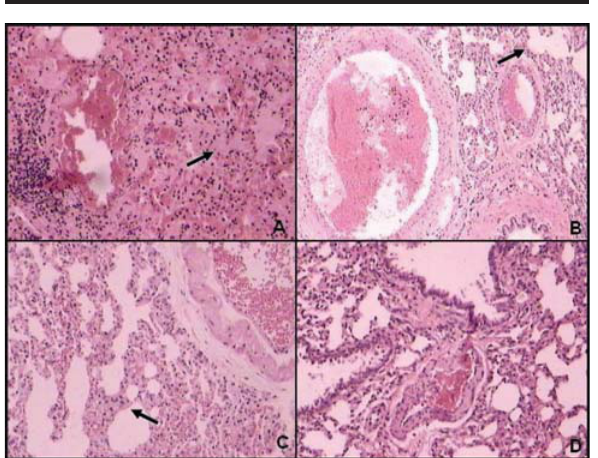
FIGURE 2 - Microscopy of the pulmonary sections of the group 10mg/kg. A) 08 weeks. The arrow shows lymphoid nodular hyperplasia (BALT hyperplasia). B) 10 weeks. Diffuse chronic inflammatory process. The arrow indicates lymphoid nodular hyperplasia (BALT). C) 12 weeks. Focal chronic inflammatory processes. The arrow indicates thickness of the alveolar wall. D) 14 weeks. Lymphoid nodular hyperplasia (BALT). (HE, 100X)